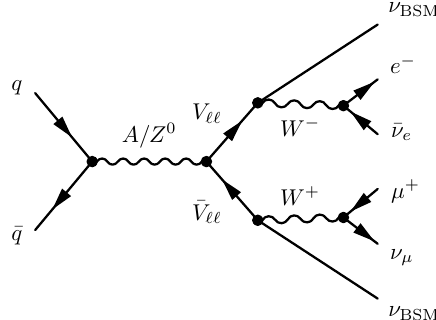
Figure 2. Leading-order Feynman diagram for the ZA topologies. Here, q and ¯ q correspond to quarks originating from the colliding protons, V BSM neutrino. There are two purely SM leptonic final channels identified with ‘ and ν